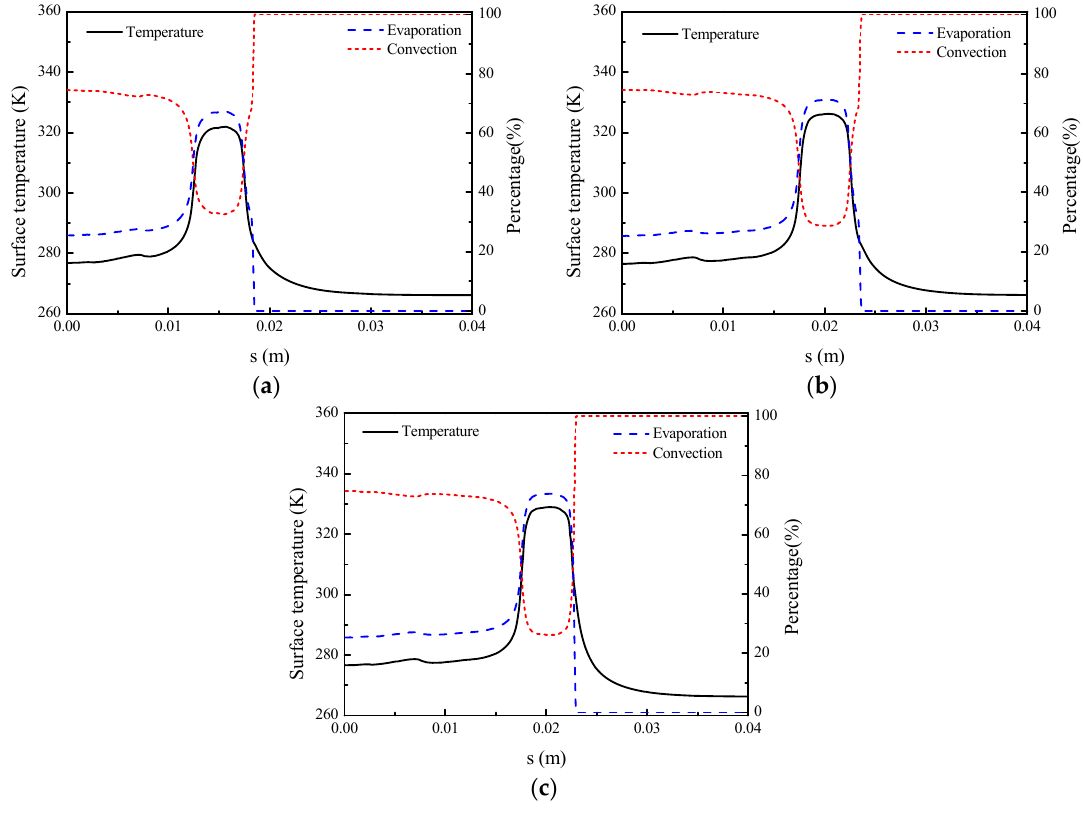
and Q : ( a ) Case 1; ( b ) Case 2; ( c ) evap conv